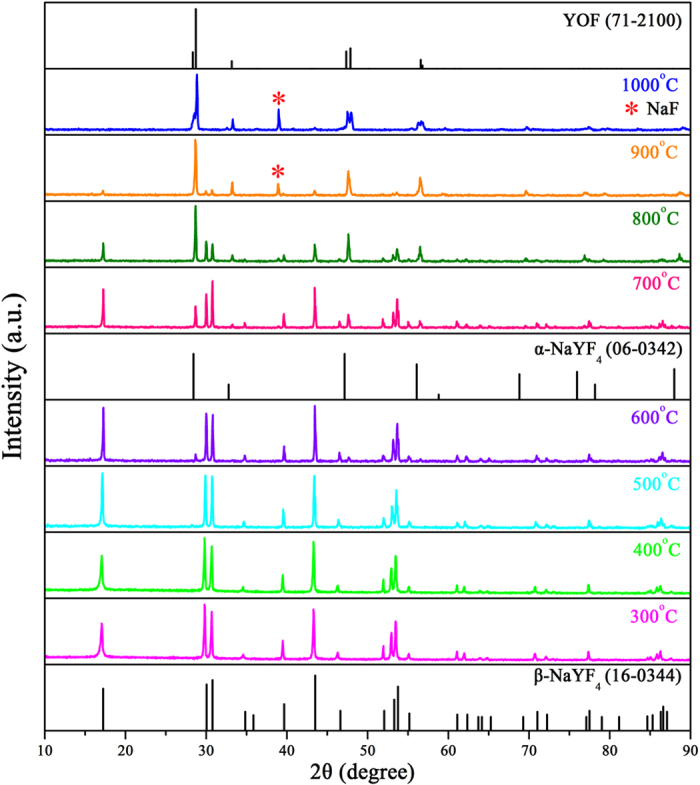
XRD patterns of β-NaYF4:5%Er3+ nanocrystals calcined at different temperatures for 2 h.